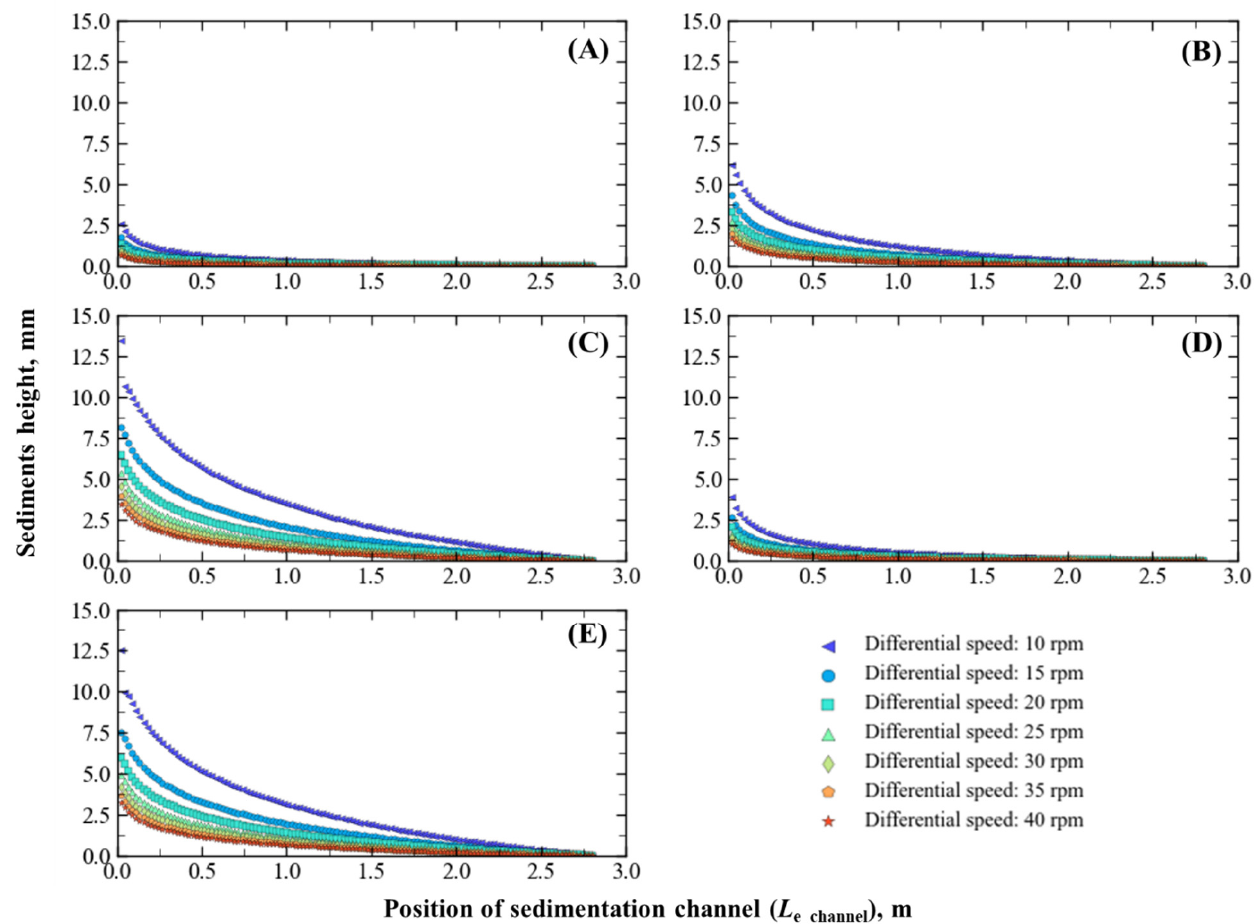
Figure 6. Sediments height along the sedimentation channel: ( A ) feed rate at 0.0005 m 3 /s and feed solids concentration at 2%; ( B ) feed rate at 0.0005 m 3 /s and feed solids concentration at 5%; ( C ) feed rate at 0.0005 m 3 /s and feed solids concentration at 10%; ( D ) feed rate at 0.0003 m 3 /s and feed solids concentration at 5%; and ( E ) feed rate at 0.001 m 3 /s and feed solids concentration at 5%.